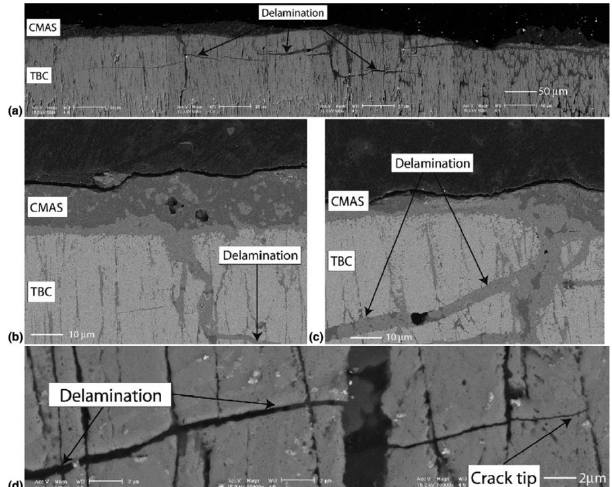
Figure 13. ( a ) Low magnification backscattered electron image of region with delamination cracks, ( b ) backscattered electron image showing phase contrast at interface TBC/CMAS, ( c ) backscattered electron image showing phase contrast in CMAS infiltrated crack, and ( d ) backscattered electron image showing CMAS infiltrated crack. Note that the intercolumnar gaps on both sides of the crack remain aligned, indicating that delamination is strictly mode I. Reprinted with permission from [31]; Copyright 2018 Springer Nature.